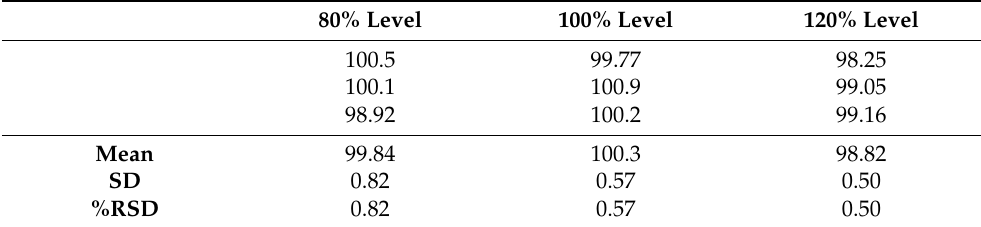
Table 2. Accuracy results.